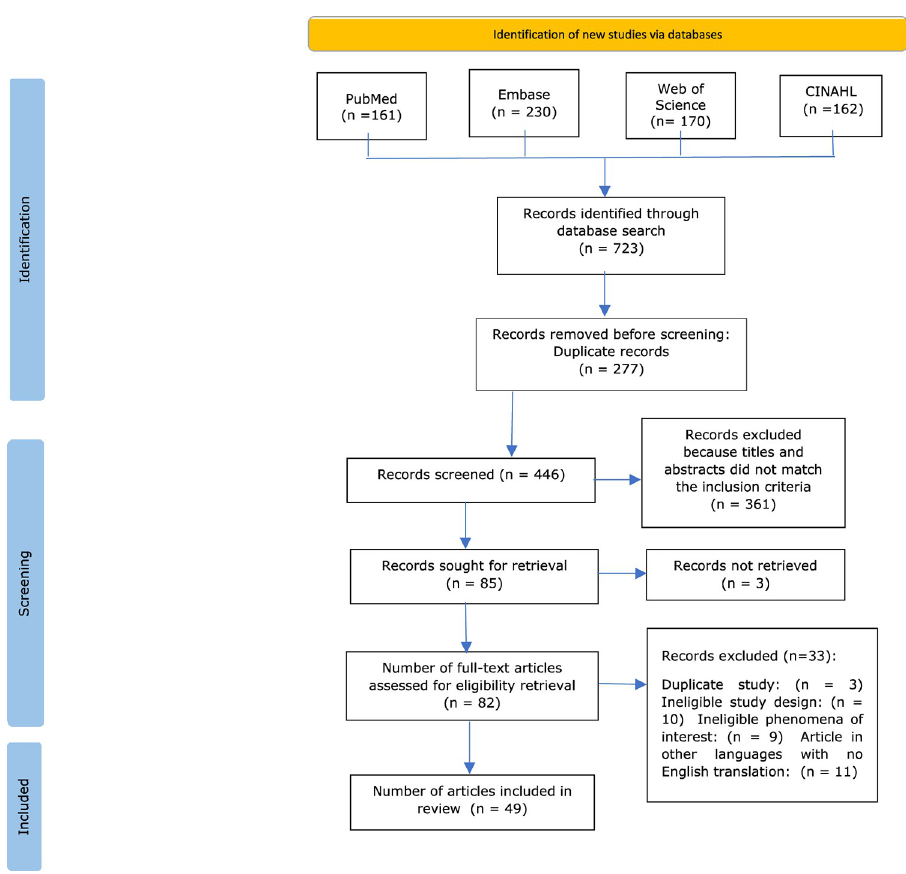
Fig 1. PRISMA flow chart of literature search results, study selection, and inclusion process.